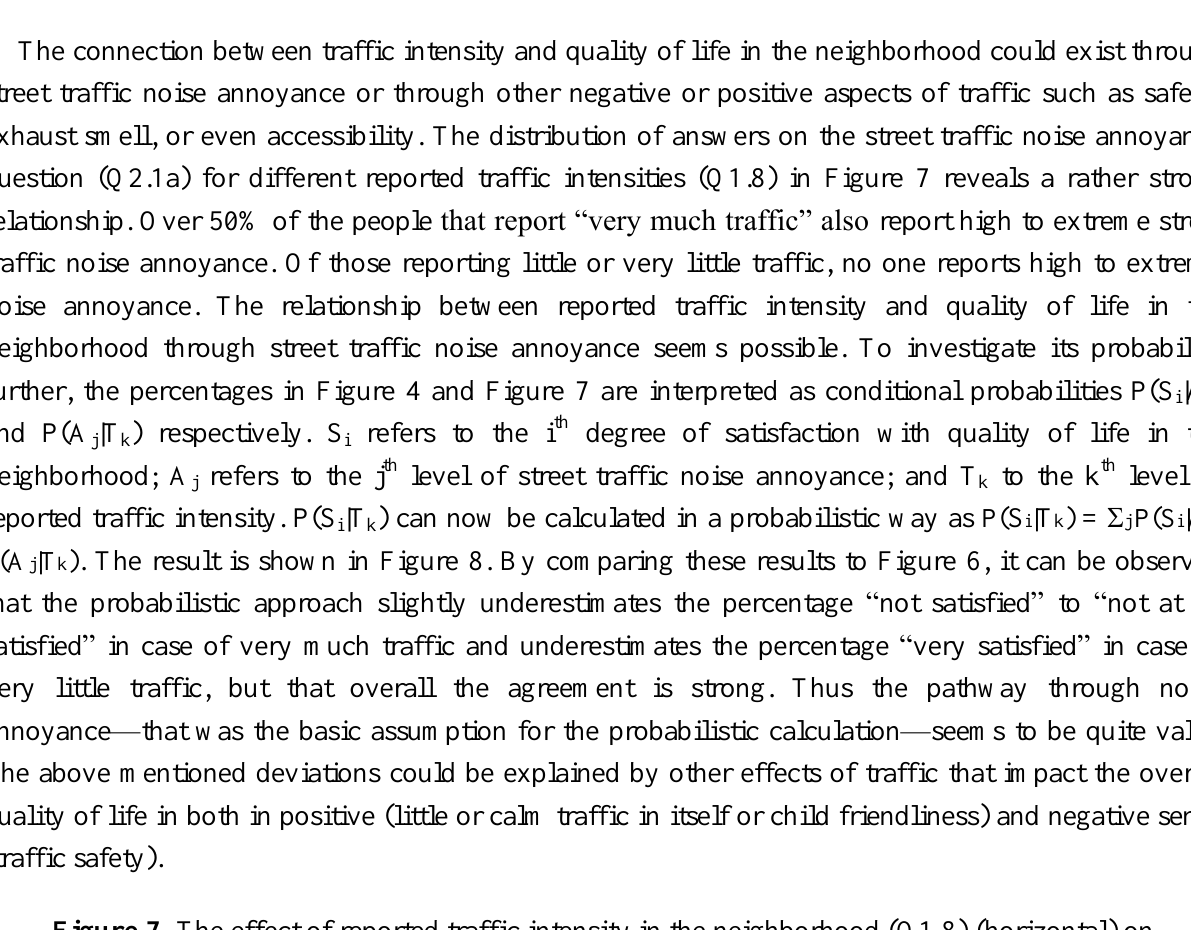
Figure 7. The effect of reported traffic intensity in the neighborhood (Q1.8) (horizontal) on the reported annoyance by street traffic noise (Q2.1a)